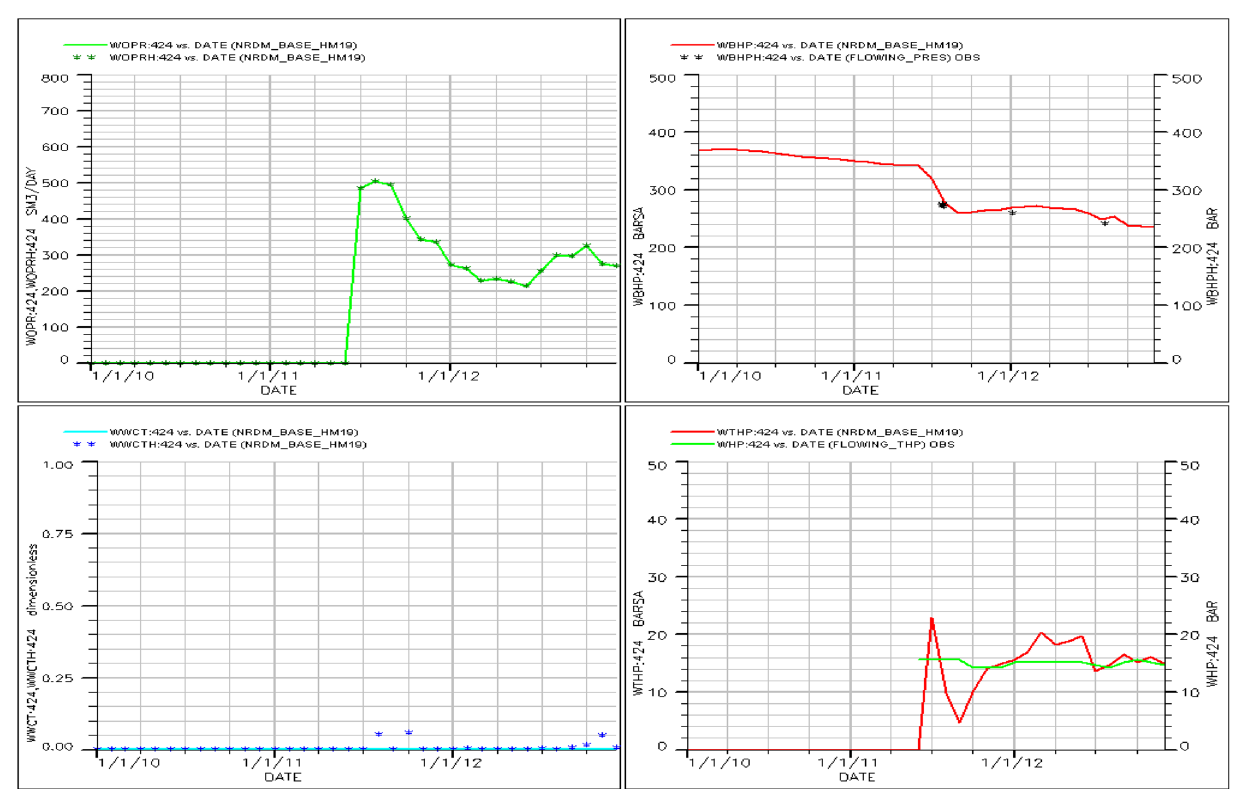
Fig. 11 Matching results of well